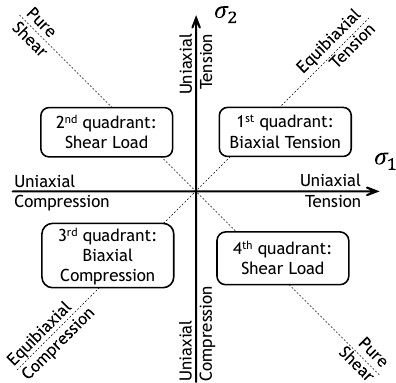
Figure 6. Schematic representation of biaxial stress states (based in [2]).